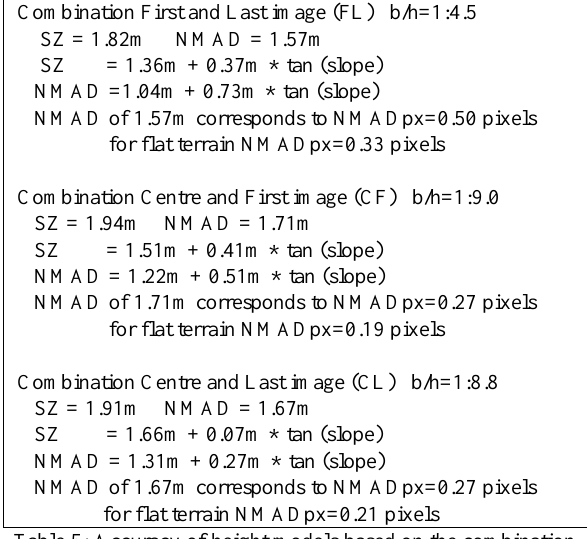
Table 5: Accuracy of height models based on the combination of two Pleiades images